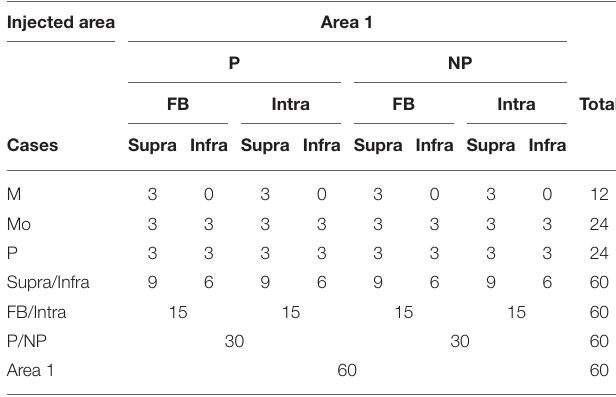
TABLE 1 | Total number of reconstructed axons labeled by area 3b injection in the different studied pathways. Injected area